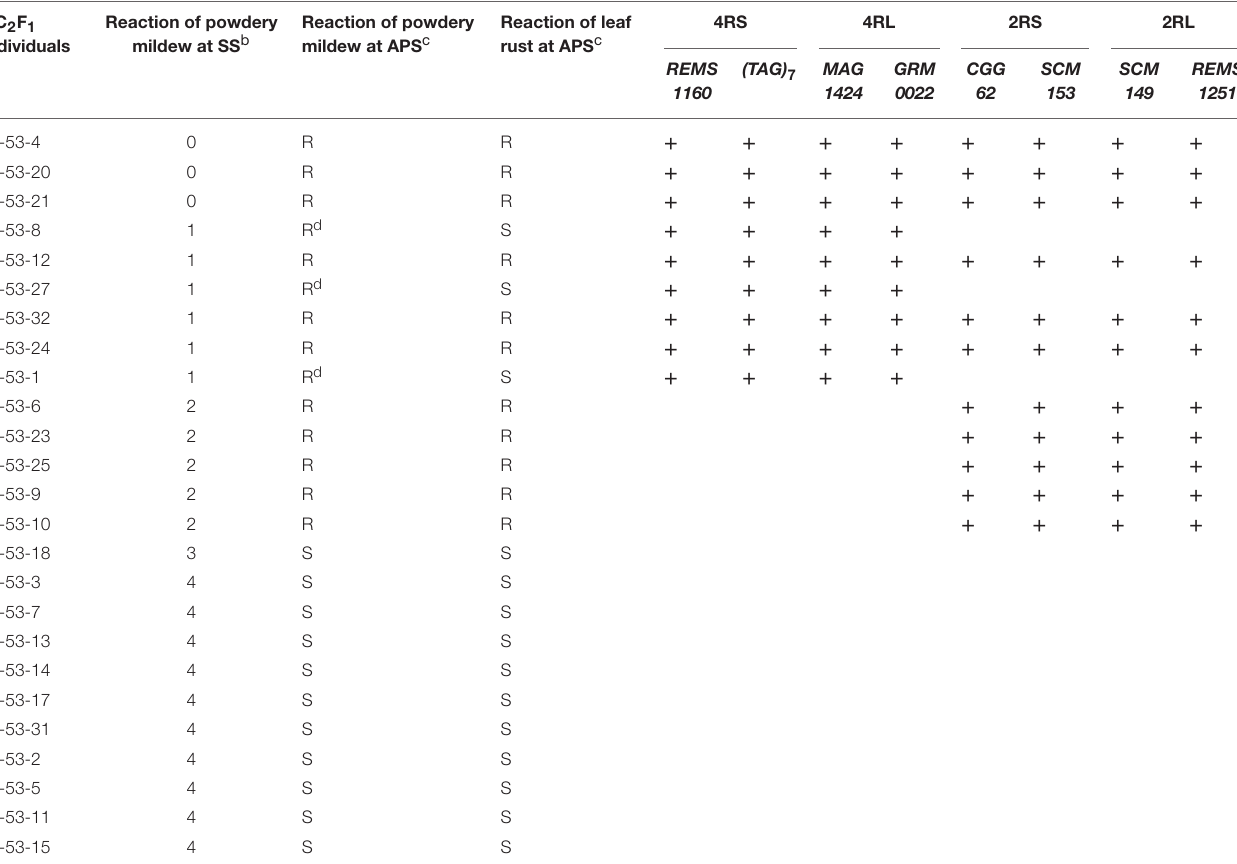
TABLE 4 | BC 2 F 1 line sx-53 segregating for 2R and 4R chromosomes a . BC 2 F 1 Reaction of powdery individuals mildew at SS b